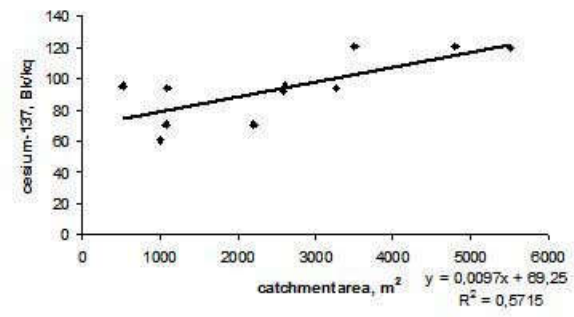
Figure 7 . Dependence of the caesium-137 specific activity on catchment area value in zone 3 (overplowed soils in watershed area).